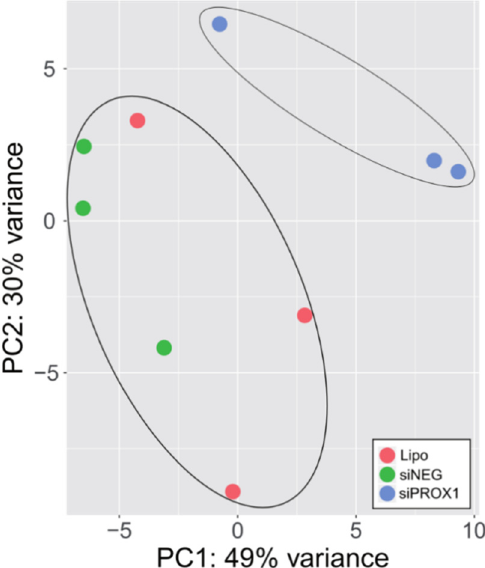
Figure 3. Principal component analysis (PCA) of RNA-Seq datasets for PROX1-depleted CGTH-W-1 cells. PCA was determined from abundance of all transcripts detected in RNA-seq survey. siNEG, siP ROX1 and Lipo: cells transfected with non-targeting siRNA, with PROX1 siRNA and with lipofectamine alone, respectively.